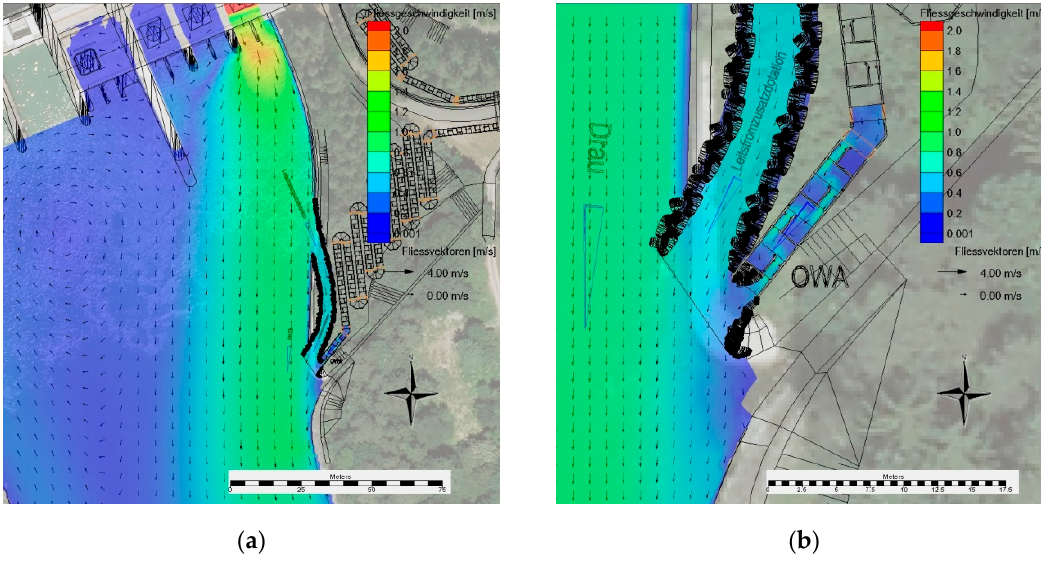
Figure 10. Alternative 5, result overview (a) and detail at entrance (b) of the 2D model. Q Drava = 135 m³/s, Q fish pass = 0.38 m³/s + Q attraction flow = 2.9 m³/s via a bypass; competing flow